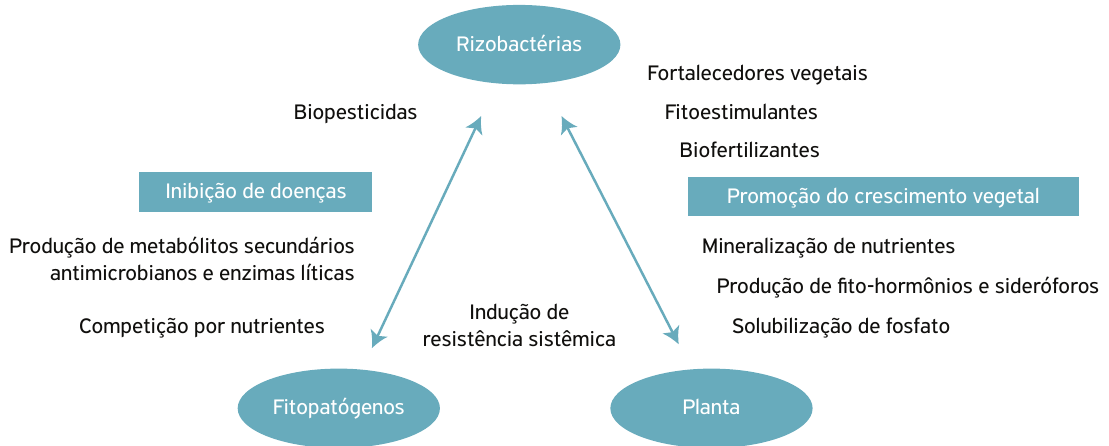
Figura 1. Interações das bactérias endofíticas na promoção do crescimento das plantas e da sanidade vegetal (adaptado de Berg ,